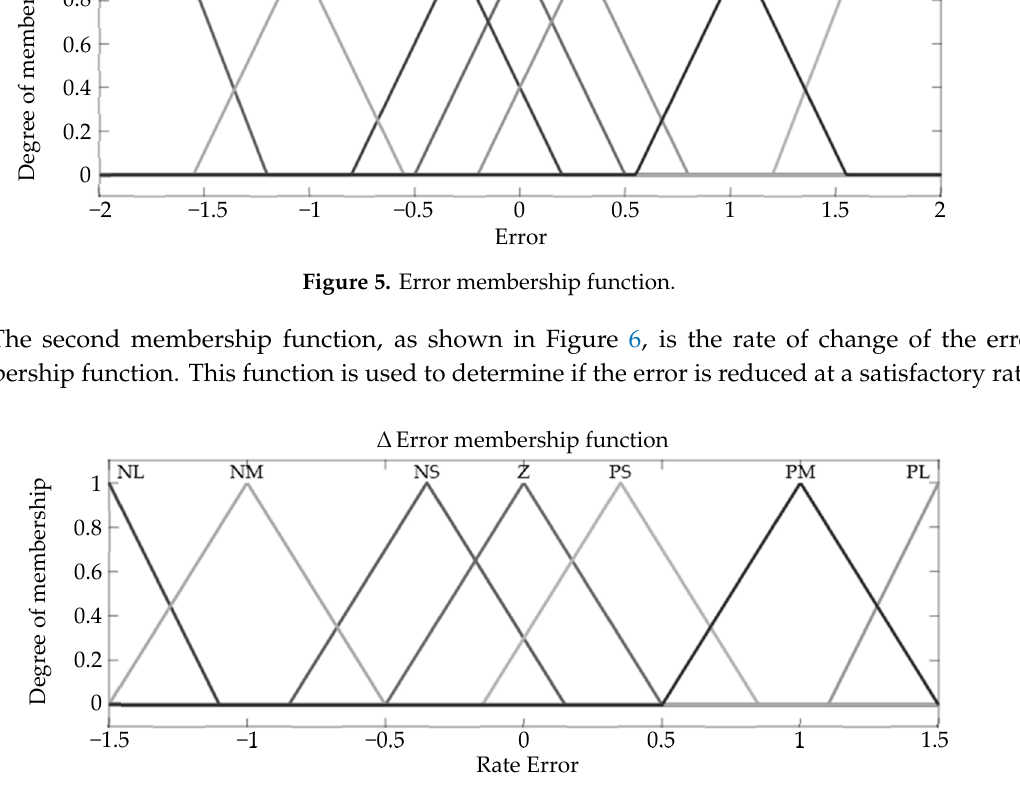
Figure 6. ∆ Error membership function. Figure 6. Δ Error membership function . Figure 6. Δ Error membership function . Figure 6. Δ Error membership function .